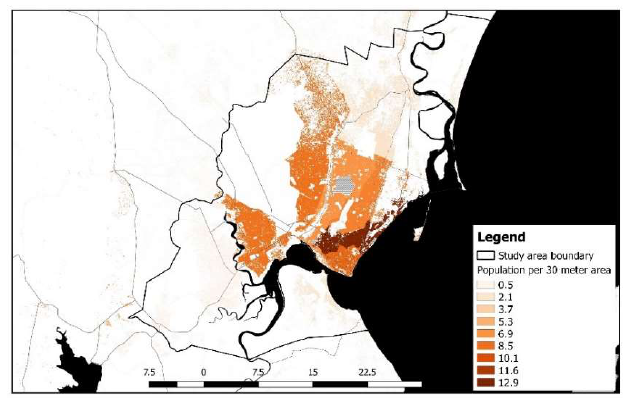
Figure 3. Image of the high-resolution settlement layer (HRSL) of Greater Maputo [7].